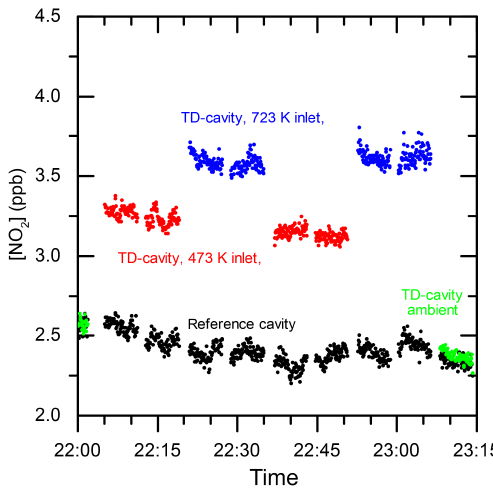
Figure 4. Example of a typical measurement cycle (showing raw data) when sampling ambient air. The black data points show the continuously measured NO 2 mixing ratios measured by the refer- ence cavity. The green, red and blue data points were recorded in the TD cavity when sampling from the inlets at ambient tempera- ture, 473 and 723K,